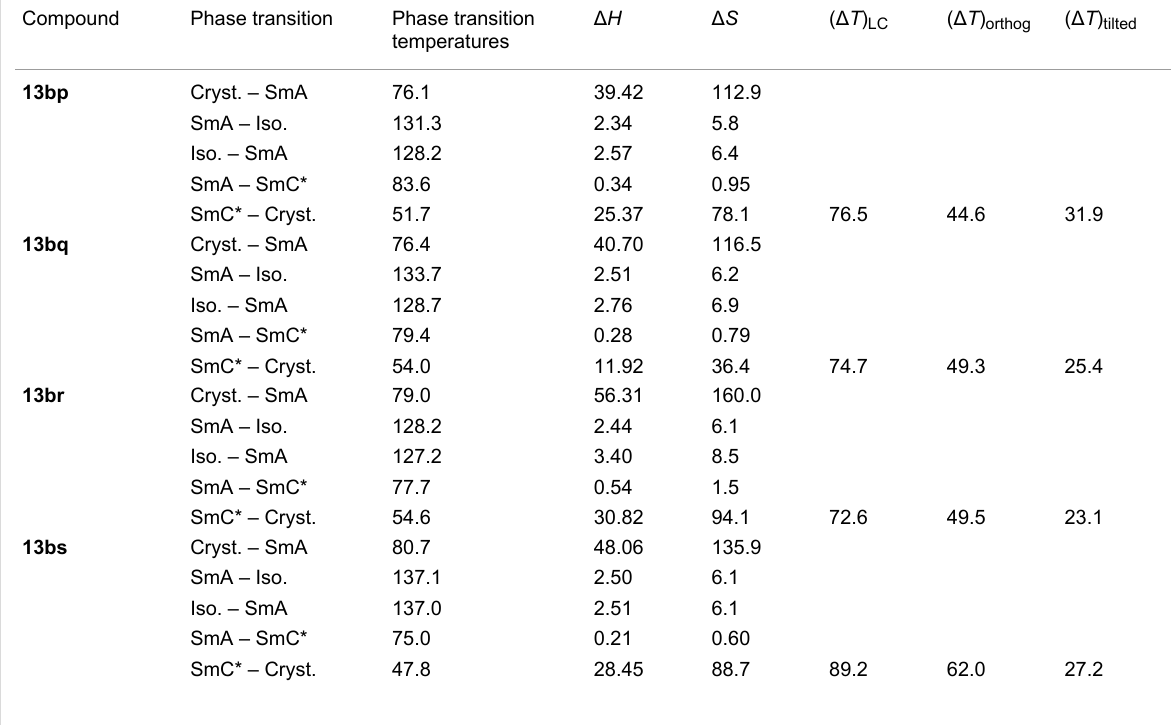
Table 2: Phase transition temperatures (°C), enthalpy changes (kJ/mol) and entropy changes (J/mol/K) of the 13b (C 12 Ox.C*C n ) series.